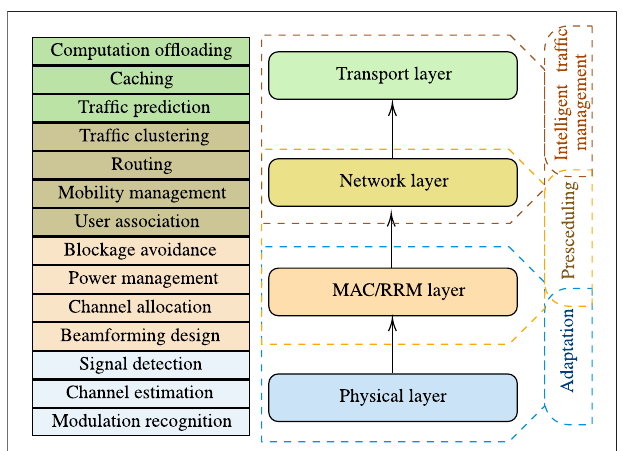
FIGURE 1 | ML-based applications to different layers of THz wireless systems and